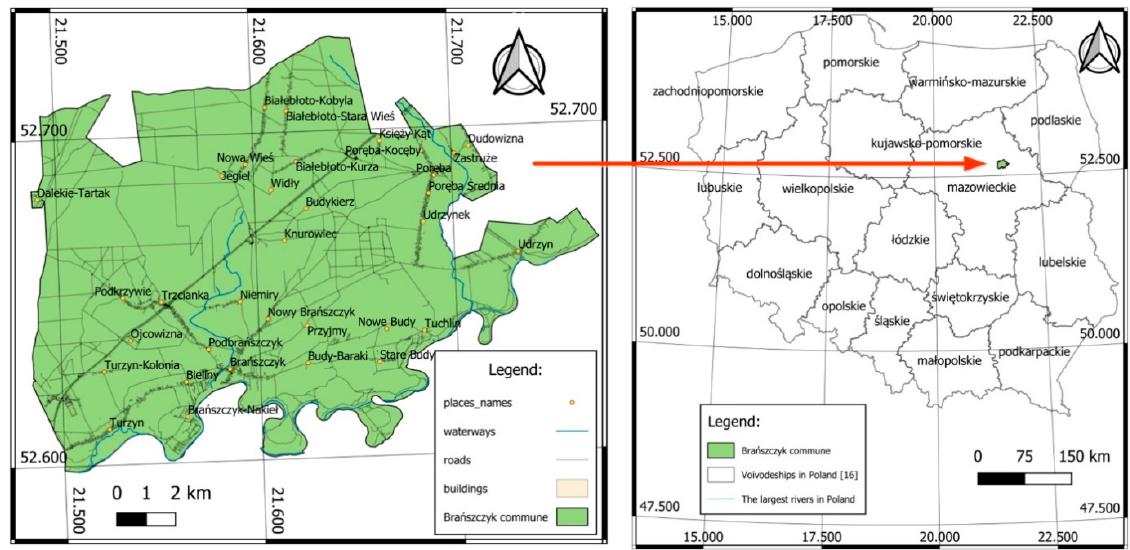
Figure 3. Maps showing the location of the case study.